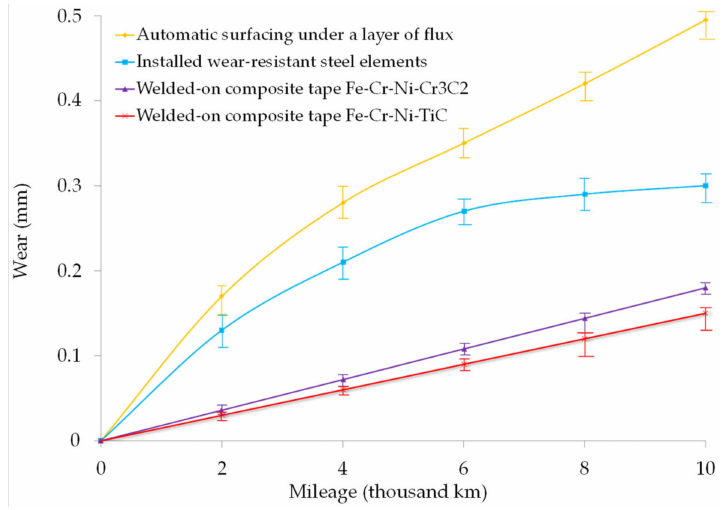
Figure 6. Experimental dependences of the wear of the CBRTB in function of the